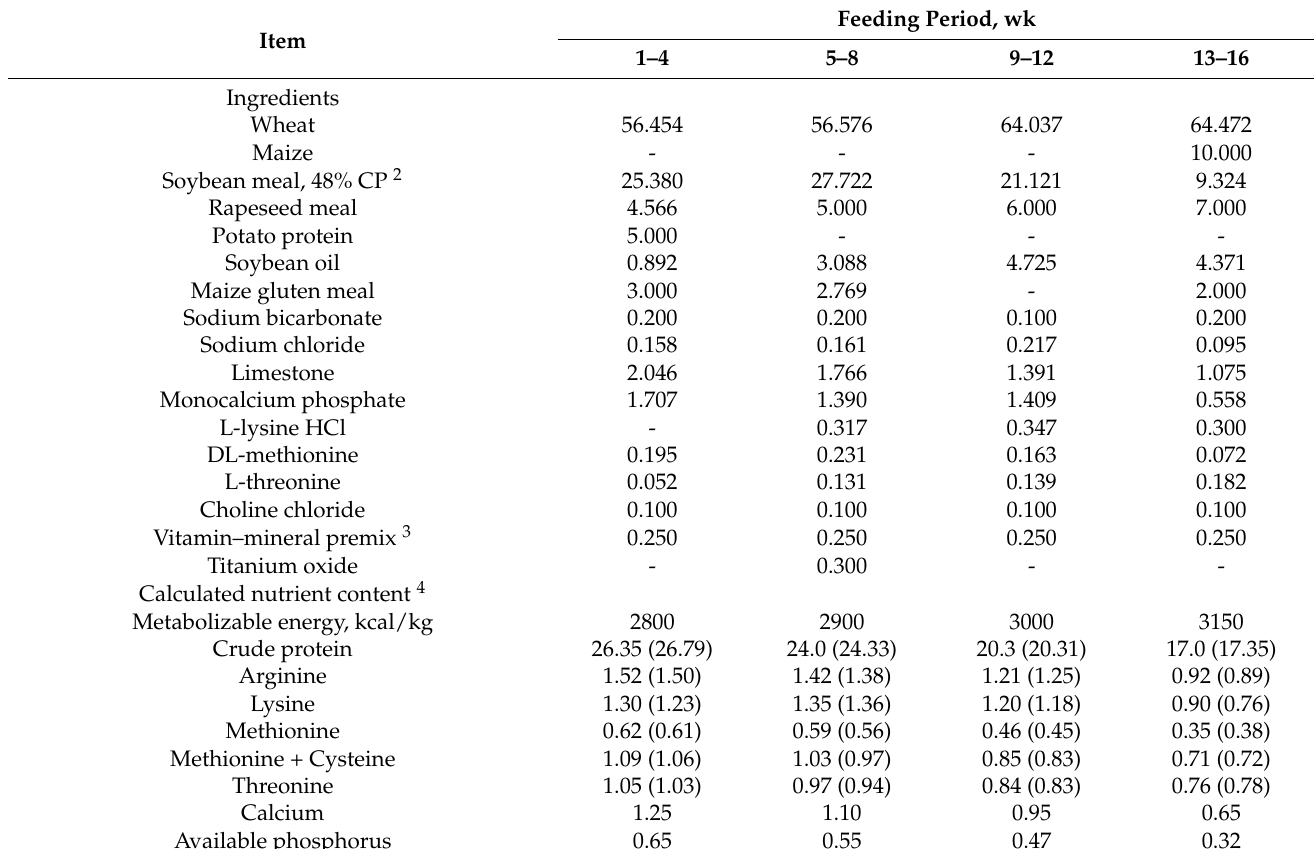
Table 1. Ingredient composition and nutrient content of basal diets (g/100 g, as-fed basis) fed to turkeys over a period of 16 wk 1